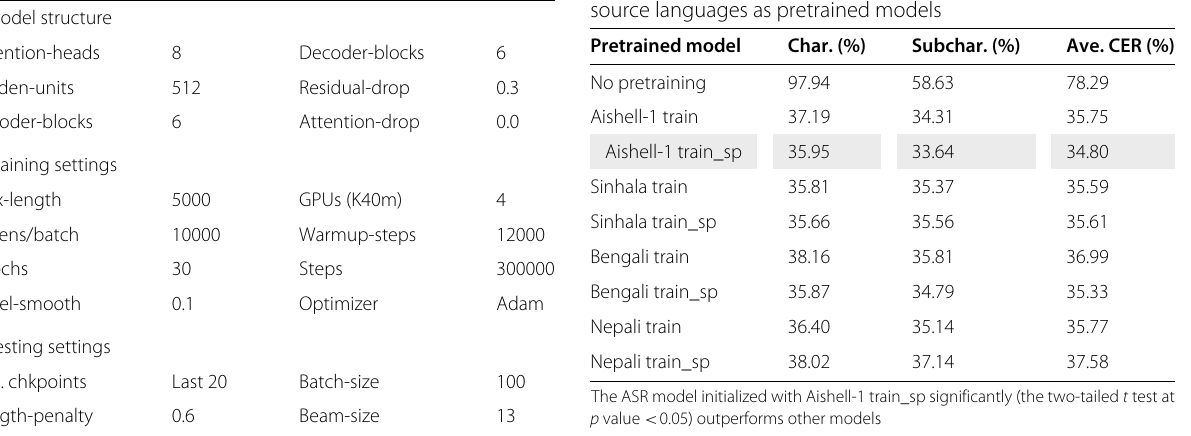
Table 2 Major experimental settings Table 3 Performance of Lhasa dialect ASR systems with four